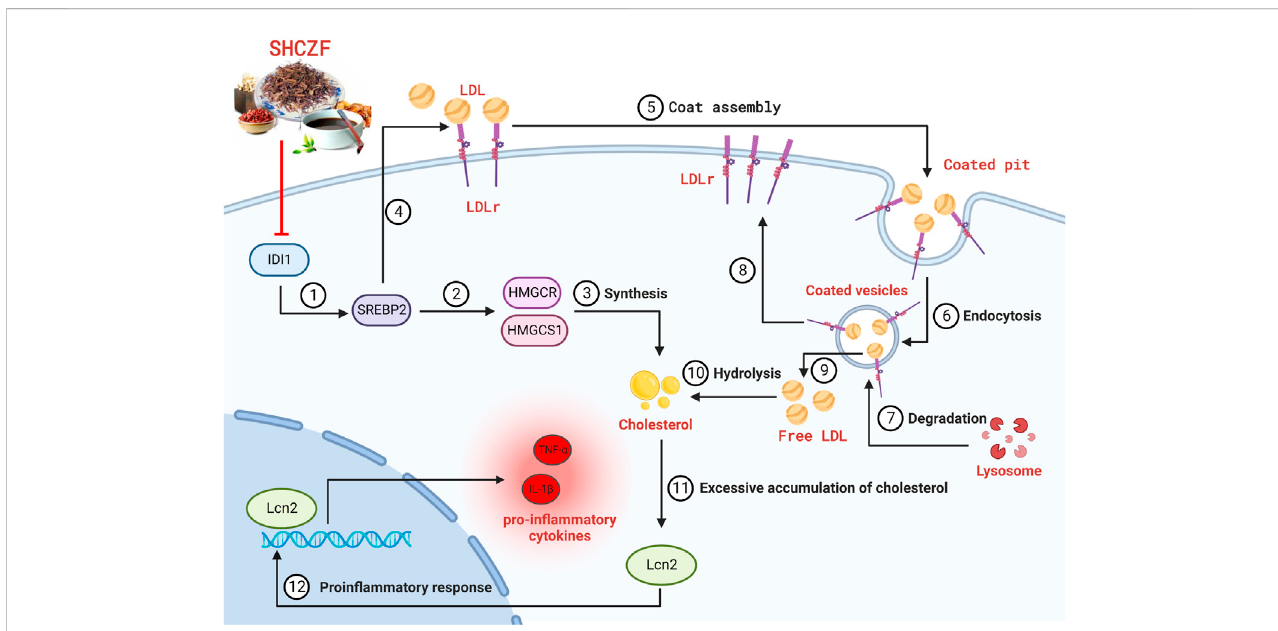
FIGURE 4 The hypothesis of SHCZF in treating AIC rats. ② , ③ The mechanism of cholesterol synthesis, ④ – ⑨ The mechanism of cholesterol uptake: Endocytosis mediatedbytheLDLron thecell surfacecanabsorbcholesterol-richLDL fromtheblood, calledtheLDLrpathway.LDLr cancombinewith freeLDL inplasma to form an LDL-LDLr complex, which appears in the coated pit, and forms coated vesicles to enter the cell. The outer skin of coated vesicles is then depolymerized, causing the separation of LDL and LDLr. LDLr returns to the cellular membrane for the next cycle, while LDL is degraded by lysosomes and hydrolyzed into free